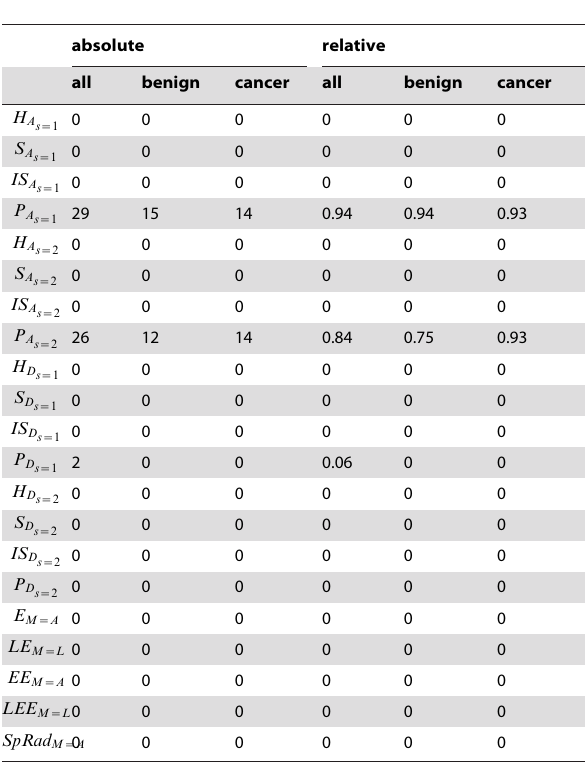
Table 5. ndV-values for the structural biomarkers (eigenvalue and entropy-based measures) for prostate cancer networks and the corresponding subgroups (benign/cancer) for